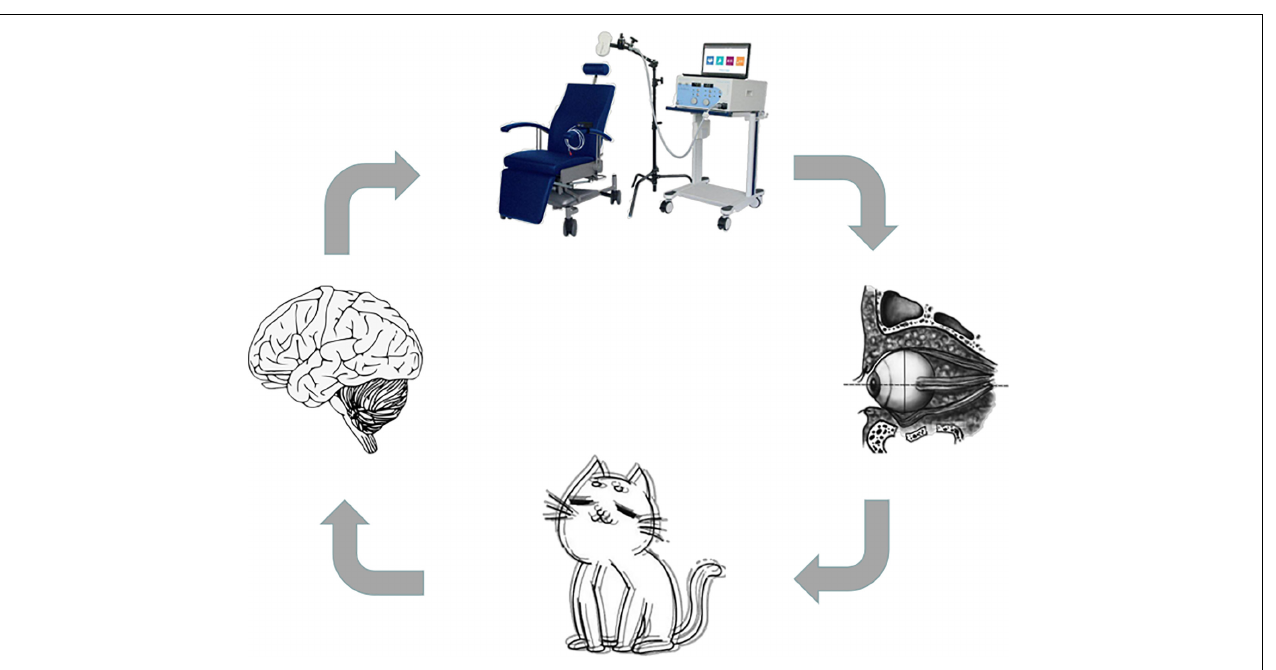
values in several brain areas between POT and PRT stages.